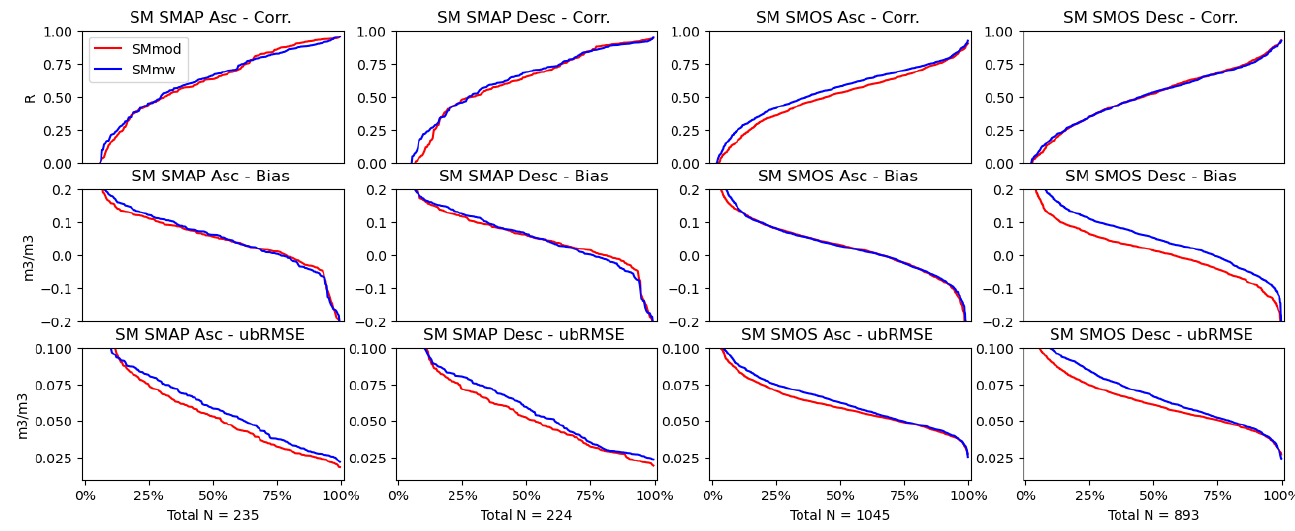
Figure 6. Cumulative plots of global SMAP Asc, SMAP Desc, SMOS Asc, and SMOS Desc SM mw and SM mod retrievals compared to in situ data from the ISMN. Results are shown for correlation (Corr.), bias, and ubRMSE.